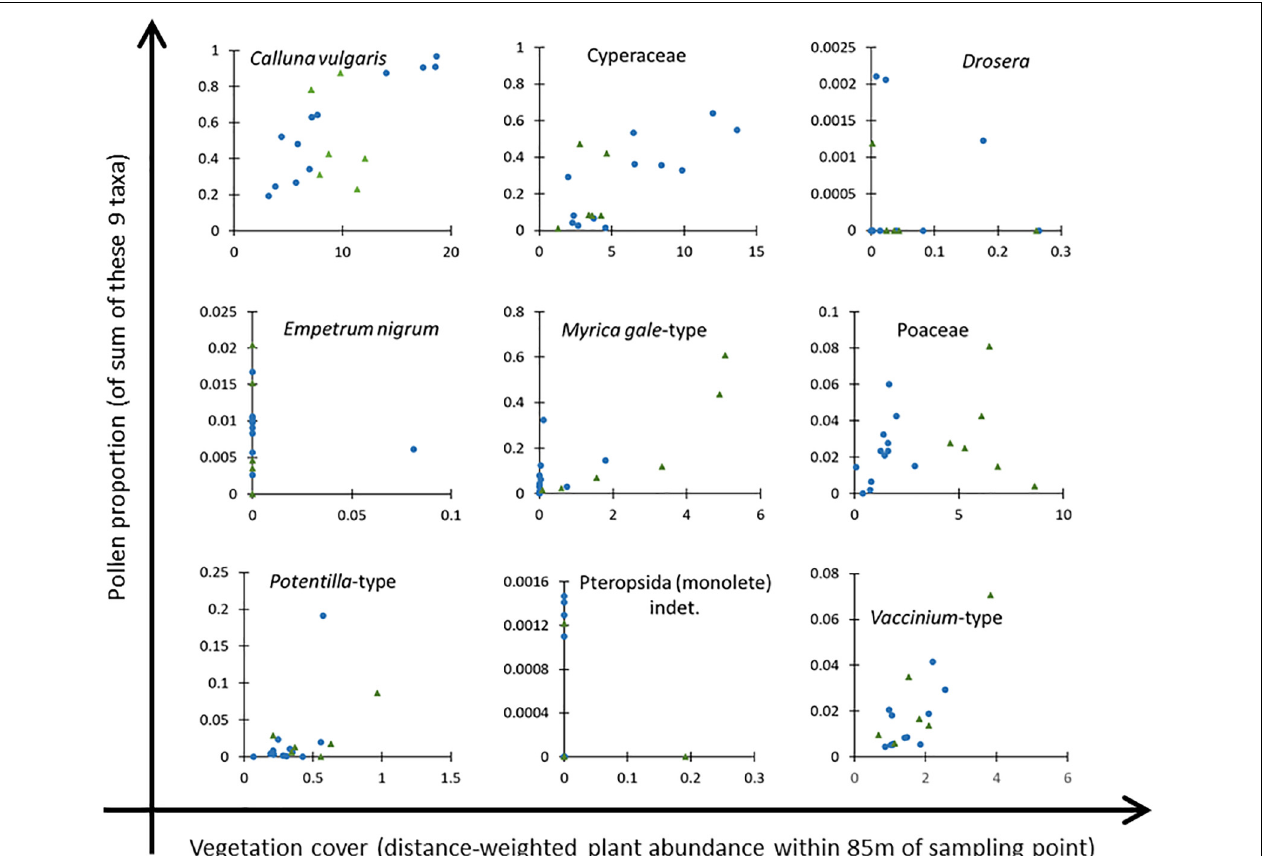
FIGURE 5 | Scatter plots of pollen proportion (on a base sum of these nine taxa) against distance-weighted plant abundance within 95 m radius of the sampling point for nine taxa considered for analysis. Drosera , Empetrum nigrum and Pteropsida (monolete) indet. were excluded from the final dataset. Blue circles denote samples in Cluster 1, green triangles samples in Cluster 2 (see Figure 3 and text for